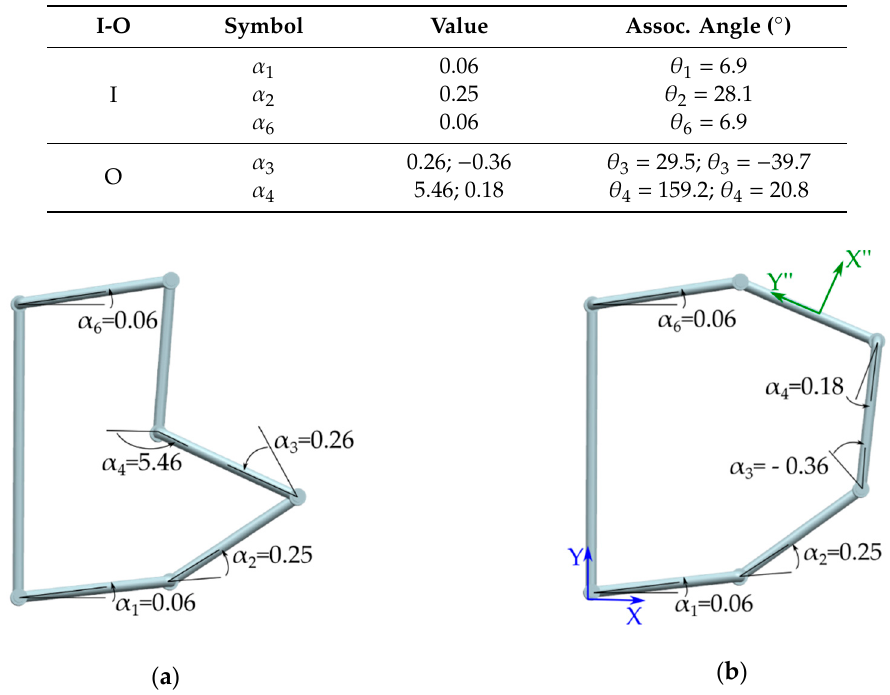
Figure 3. Solutions for the 6R closed loop mechanism with input values for α 1 , α 2 and α 6 : ( a ) “concave” pose and ( b ) “convex” pose.